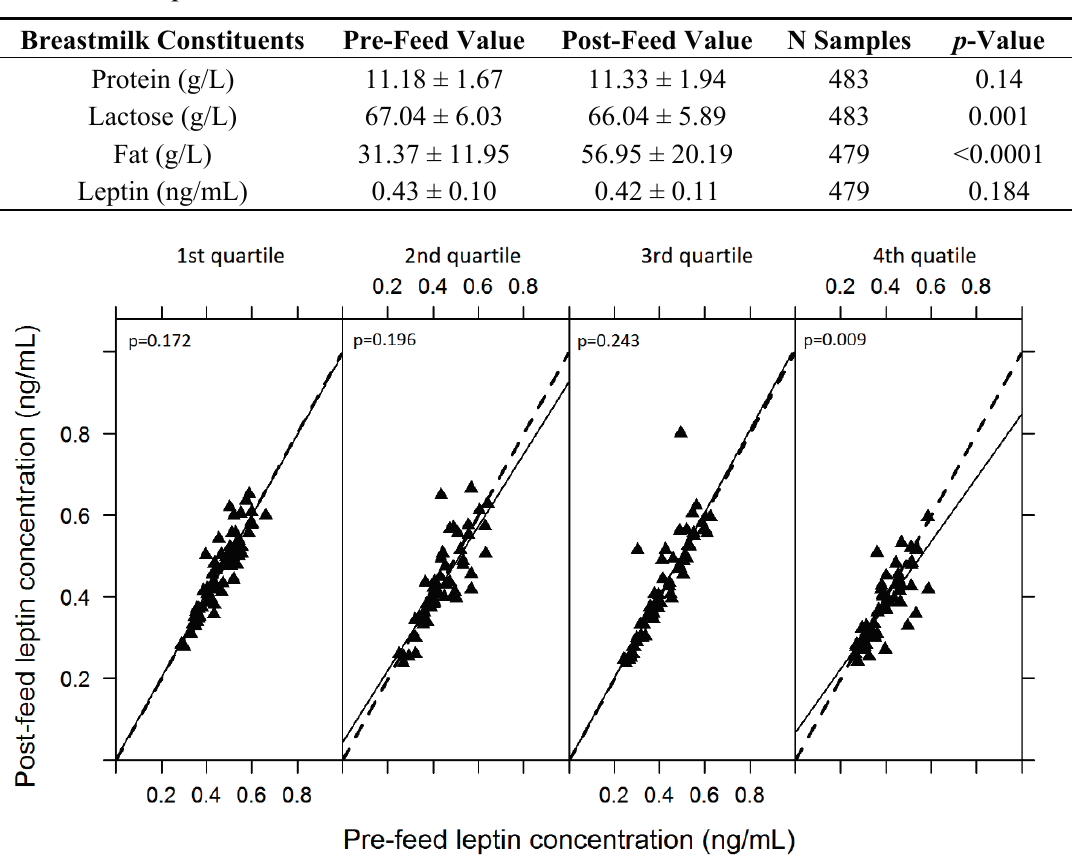
Table 2. Breastmilk concentration of protein, lactose, fat and leptin in 19 breastfeeding